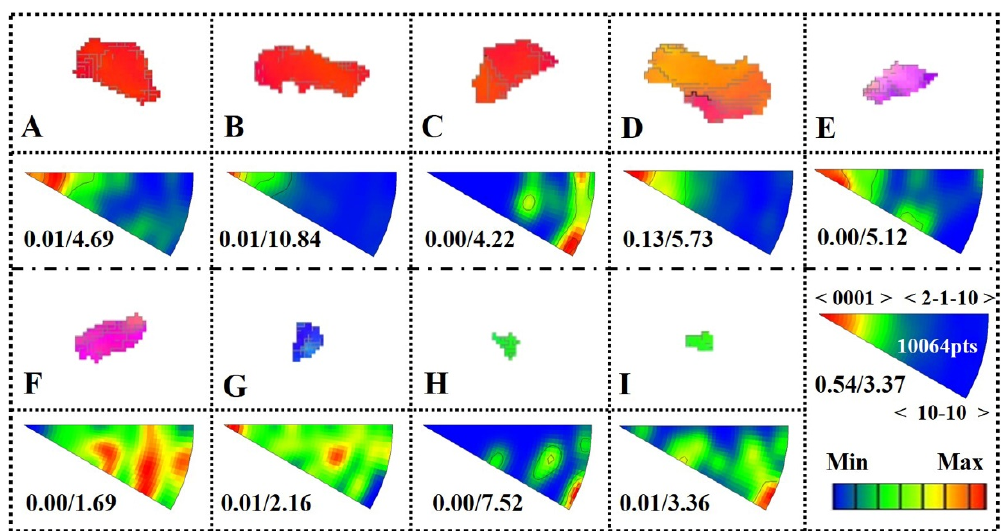
Figure 7. Selected grain A–I from Figure 4a, the corresponding IGMA distribution below the selected grains map are used to determine the activated slip modes. The overall IGMA distribution of Figure 4c is shown in the bottom right corner. The maximum and minimum intensities of the IGMA distribution are also given at the bottom of each IGMA distribution. Intensity values less than 2.0 are considered IGMA without concentration.